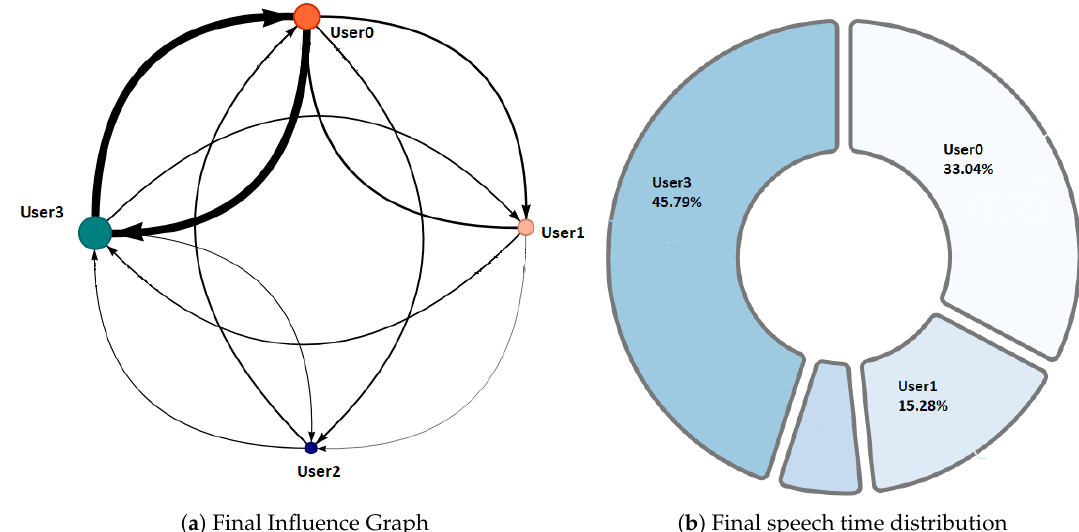
Figure 10. Final Behavior observed in G2.